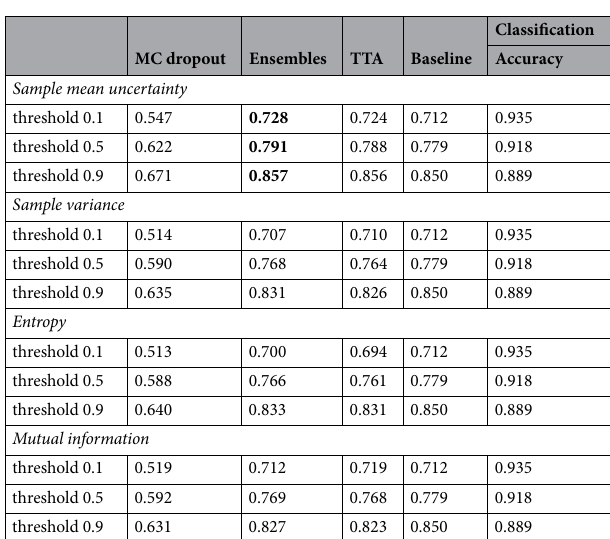
Table 5. BRLN data: ROC AUCs of misprediction detection for varying classification thresholds. The highest achieved values per classification threshold are in bold.